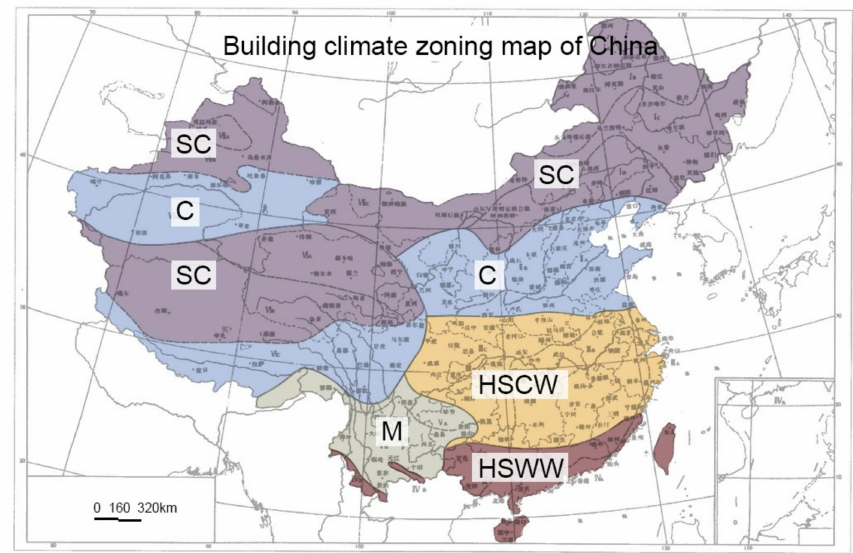
Figure 1. Building climate zoning map of China.